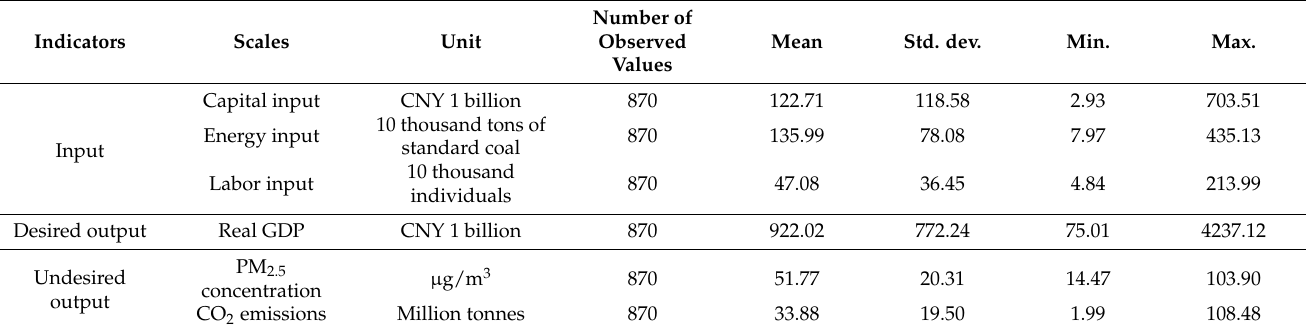
Table 1. Descriptive statistics of inputs and outputs from 2006 to